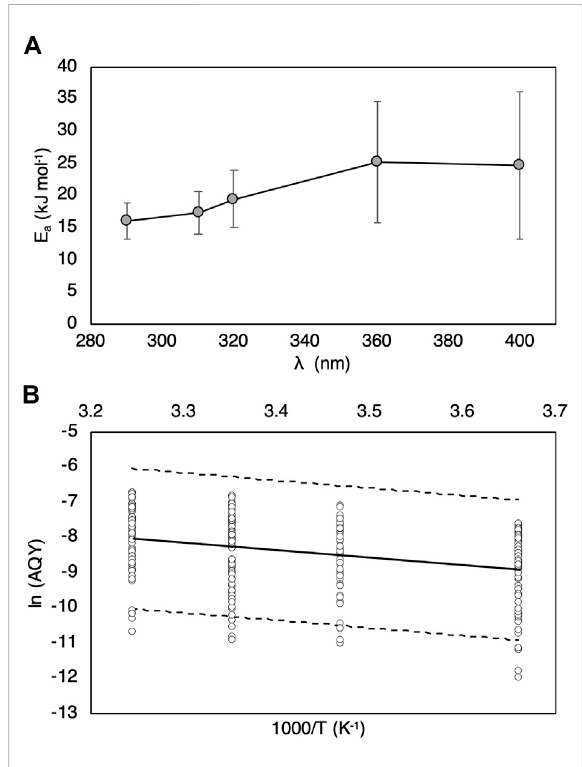
FIGURE 4 (A) Average activation energies ( E a ) and 95% CI determined from the slope of the linear regression ln [ Φ ( λ )] versus 1/T (K − 1 ) for AQY data at each wavelength. (B) ln (AQY) versus 1,000/T (K − 1 ) (best- fi t line is shown in solid black line; 95% prediction interval is bracketed by dashed lines) for all AQY data at from 0 — 35 ° C (gray dots) reported in Kieber et al.